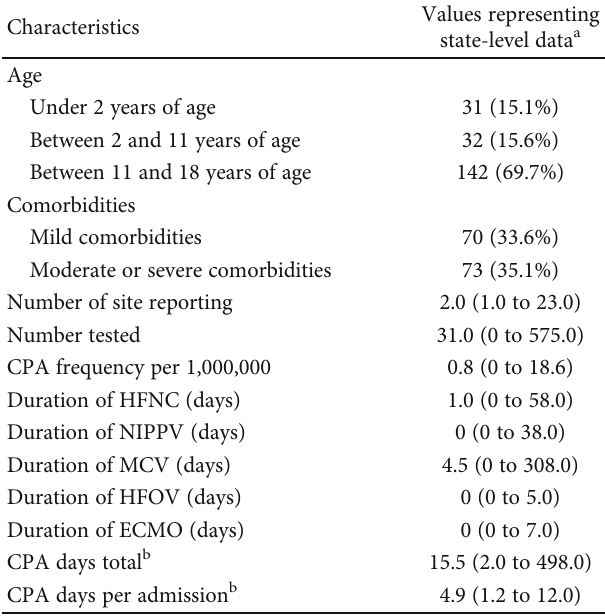
Table 1: Demographic characteristics and outcomes of children treated in pediatric intensive care units for COVID-19 in the United States of